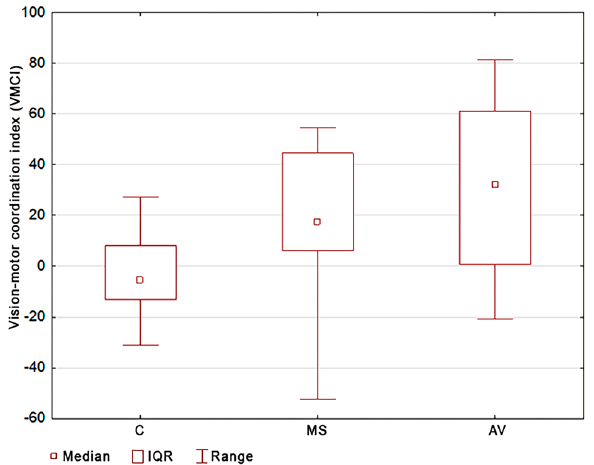
Figure 4. Comparison of the size of the vision-motor coordination index between the